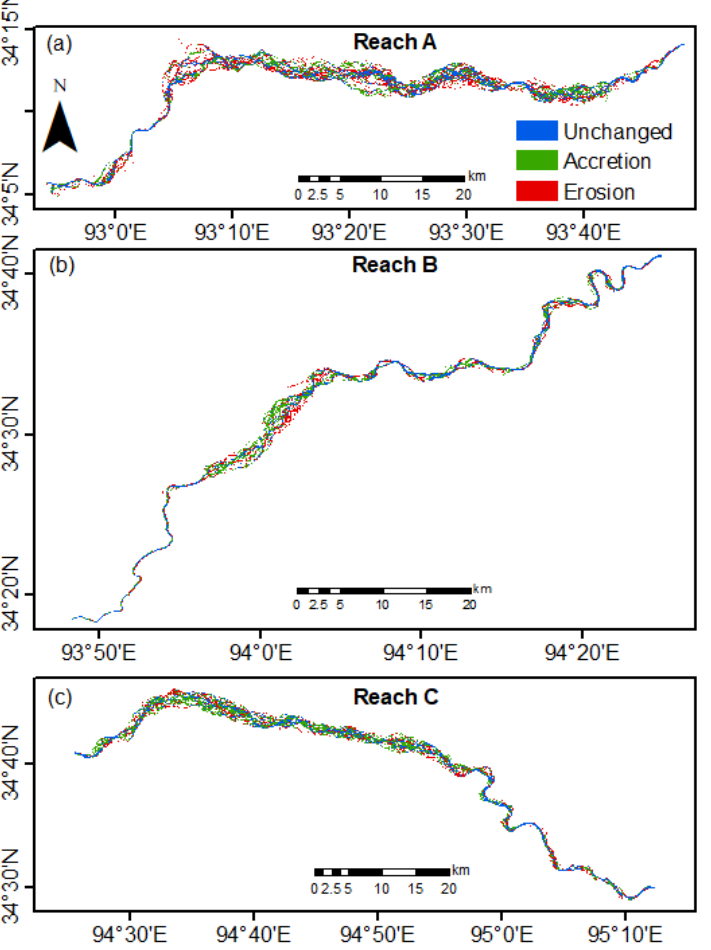
Figure 6. Maps showing channel morphology dynamics for the main braided reaches A ( a ), B ( b ), and C ( c ) of the Tongtian River during 1990–2020.